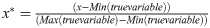
Overview of absolute differences between true and recovered network characteristics of shrinkage (blue), ridge (orange), and lasso (green) estimated partial correlations, and of pairwise correlations (red), in the condition where the correct number of edges is selected.For node characteristics (i.e., degree, strength, and betweenness), sums of absolute differences of linearly transformed variables x* are shown (x*=(x−Min(truevariable))(Max(truevariable)−Min(truevariable)); i.e., 0 was mapped on the minimum of the true variable, and 1 was mapped on the maximum of the true value). SWI = Small-worldness index, CC = Clustering coefficient, APL = Average path length, #Comp = Number of components, n = Number of observations. NB: x-axis on logarithmic scale; if absolute difference is zero, the method’s symbol is not shown.